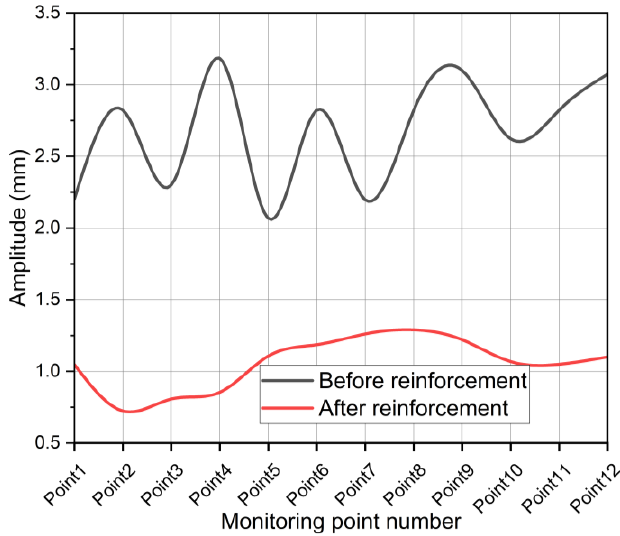
Figure 13. Maximum amplitude of bridge deck before and after reinforcement (unit: mm).